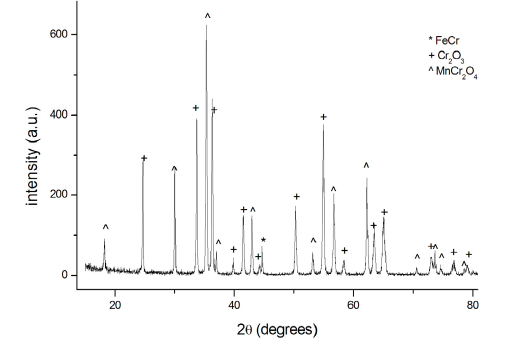
Figure 2: XRD spectrum of uncoated Fe-20Cr alloy specimen oxidized for 200h at 1000 ºC.